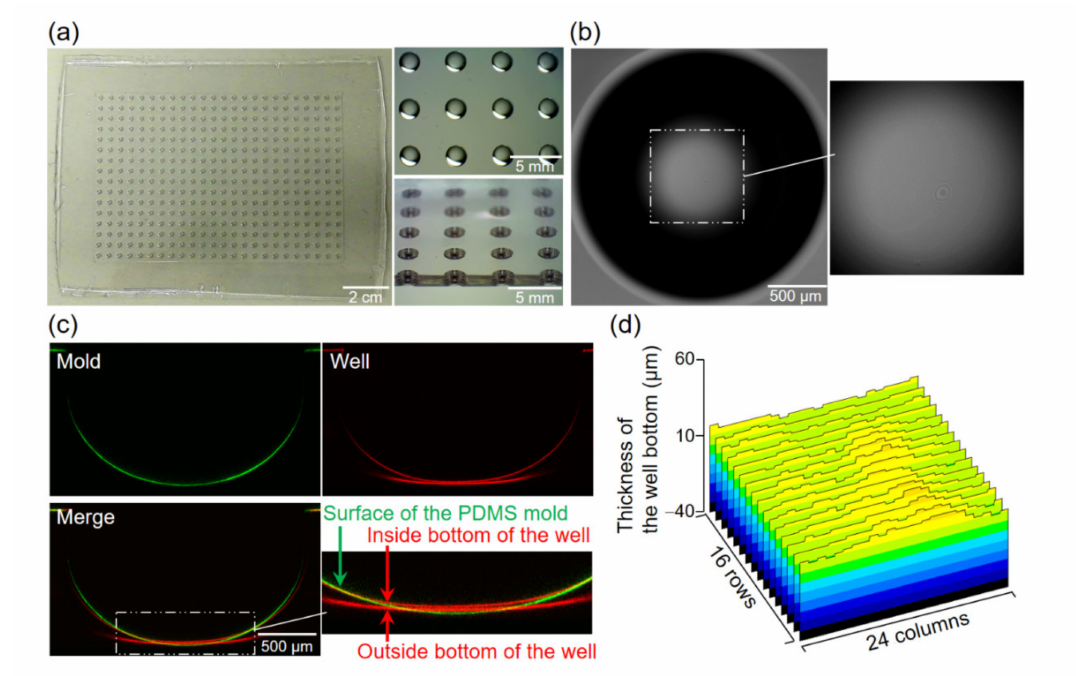
Figure 4. Characterization of the newly developed 384-well plate and comparison with the mold. ( a ) Left: Entire photograph of the 384-well plate. Right: Close-up image of the plate from above (upper) and diagonally above with the cross-section (bottom) observed by stereo microscope. ( b ) Bright-field image of the well bottom. ( c ) Comparison of the cross-section shape between the convex of the mold (pseudo-colored in green) and the well of the plate (pseudo-colored in red), by using confocal z-stack imaging of bovine serum albumin–tetramethylrhodamine (BSA-TAMRA) coated onto their surfaces. ( d ) Thickness profile of the bottom of all wells on the plate. The width of the thickness range was set to 100 µ m for comparison with the convex height of PDMS molds (Figure